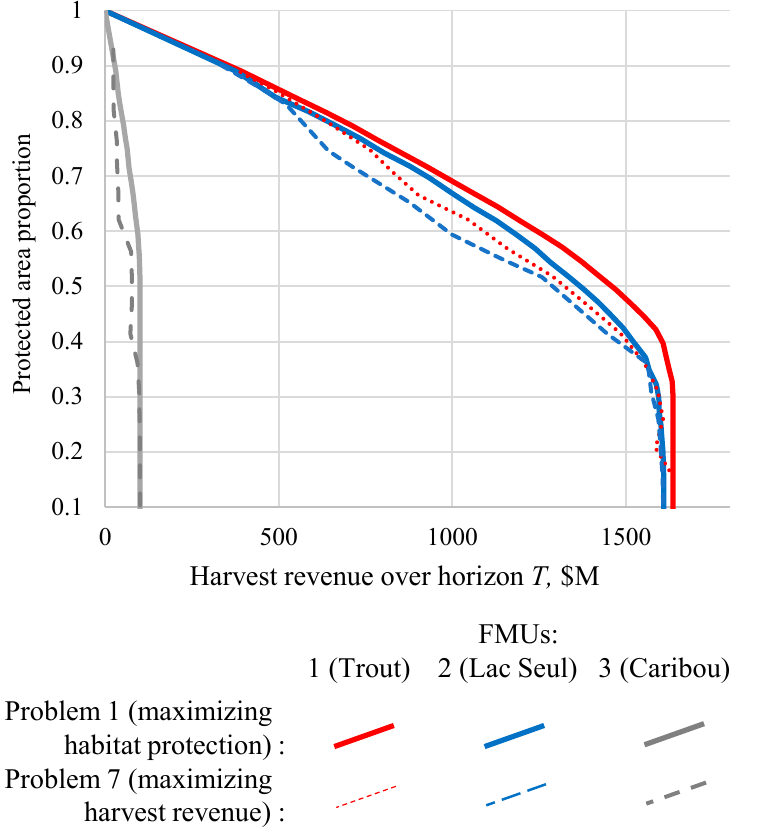
Figure 7. The proportion of protected habitat area exempt from harvest in the FMU area vs. total harvest revenue for FMUs 1–3. The curves show the solutions for problems 1 and 7, which represent the endpoints of the trade-off frontier (see Figure 4) between solutions that maximize the amount of protected habitat (Problem 1; solid lines) and solutions that maximize harvest revenue (Problem 7; dotted/dashed lines).